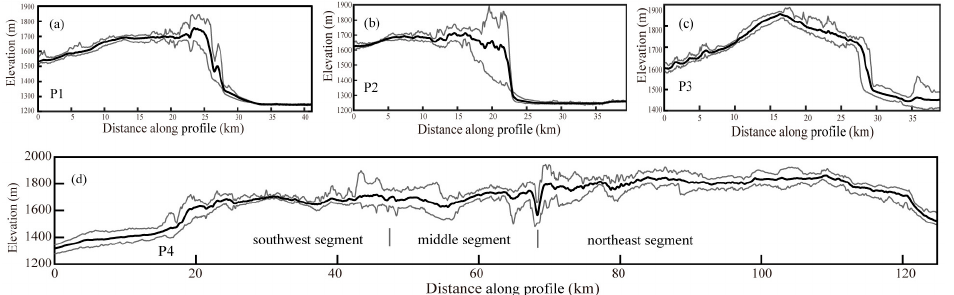
Figure 5. Swath profiles ( a ) in the southwest, ( b ) middle and ( c ) northeast of Yabrai Shan, and ( d ) along the strike of the Yabrai range-front fault. The location of these swath profiles was shown in Figure 4(a). Bold black, and upper and lower lines in the strip area denote the average, maximum and minimum elevations, respectively. The maximum, minimum and average elevations in the strip area demonstrate the topographic features of the peaks, river valleys and average altitudes, respectively.